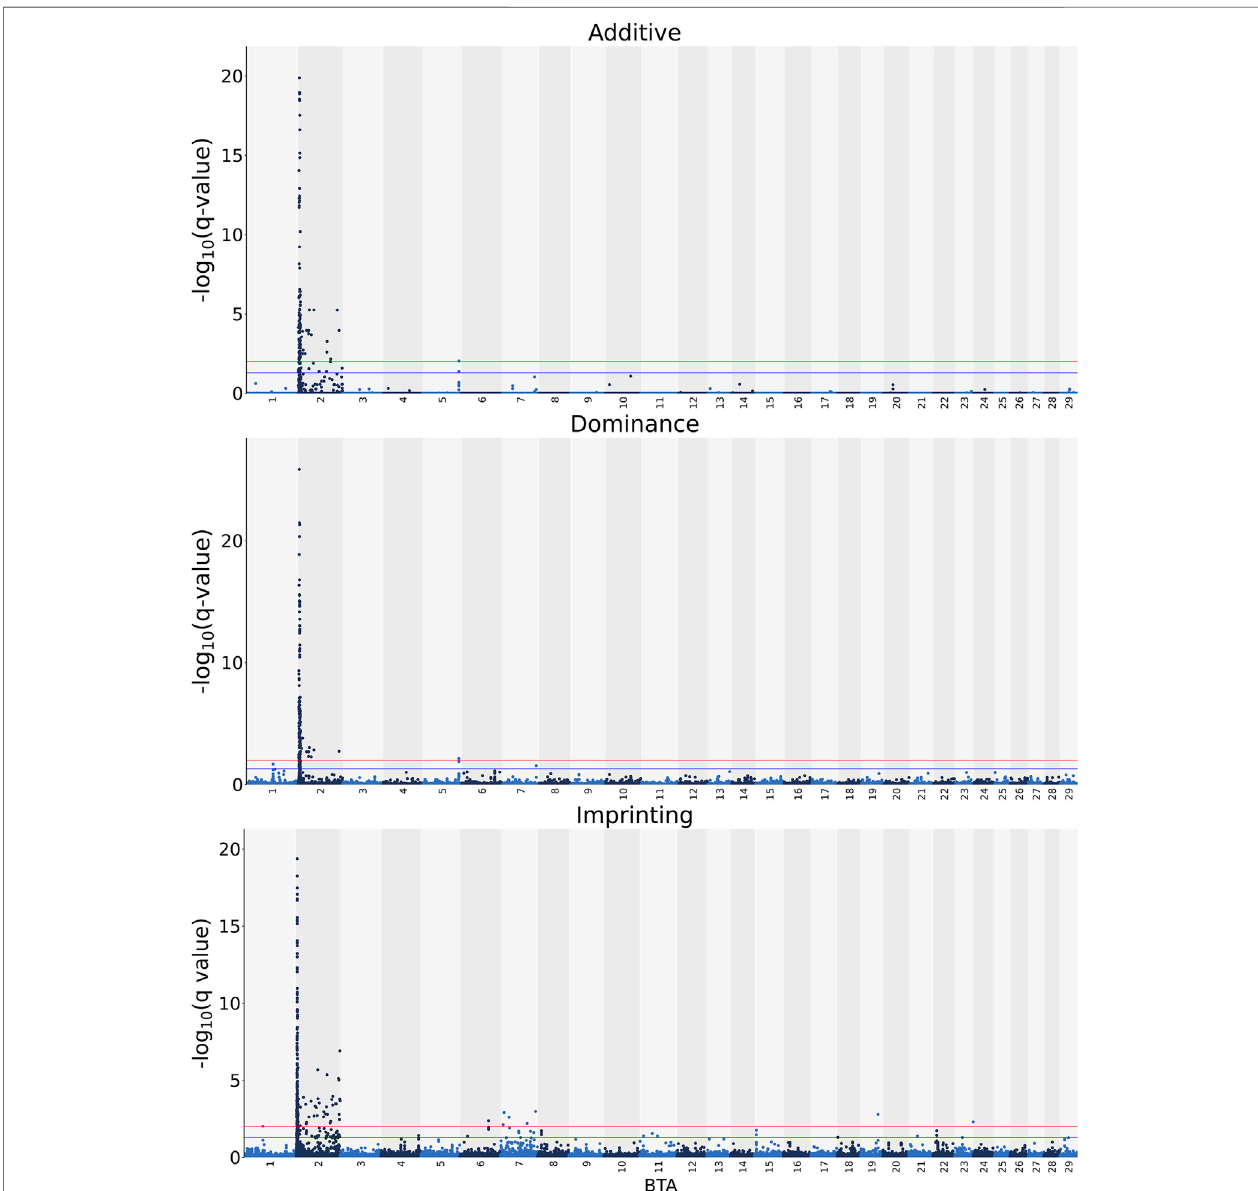
FIGURE 2 | Manhattan plots of the − log 10 (q values) for additive, dominance and imprinting associations with carcass conformation from each Bos taurus (BTA) chromosome. Blue and red lines are the thresholds for suggestive (0.01 < q value ≤ 0.05) and signi fi cant (q values ≤ 0.01) SNPs, respectively.